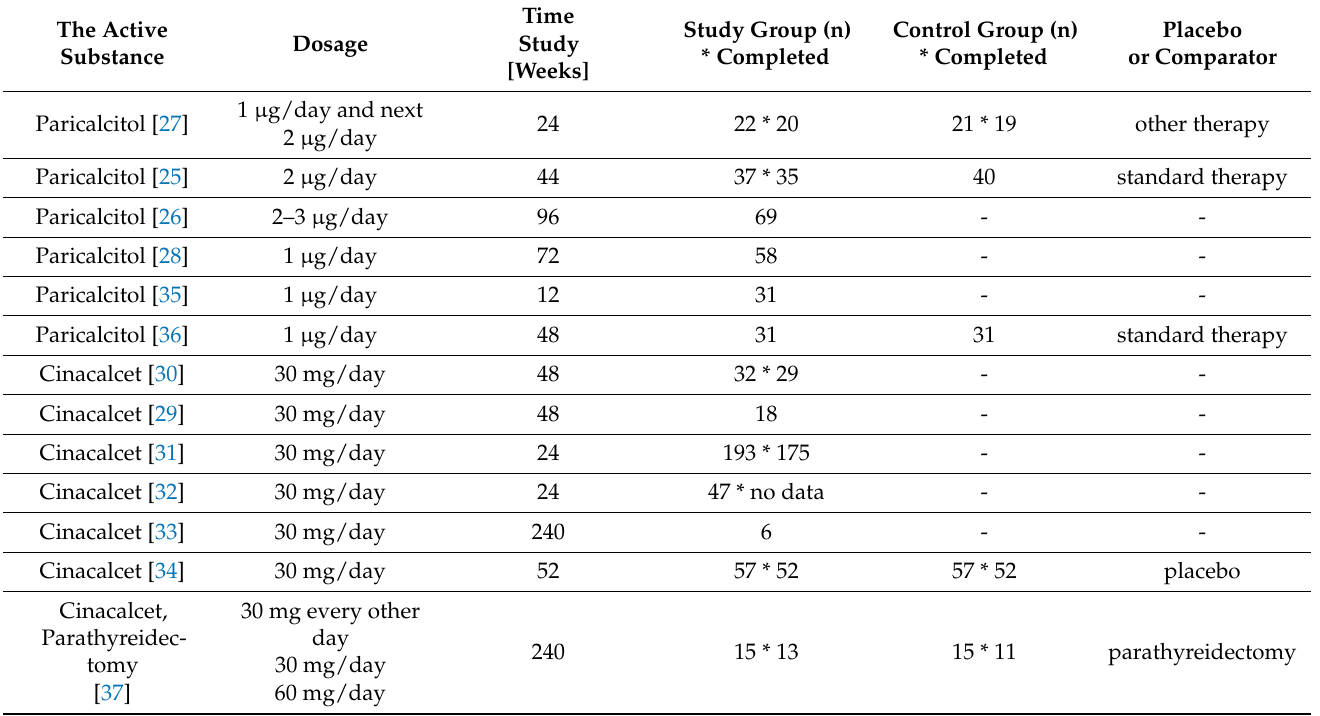
Table 1. Selected information with regard to the analysed studies